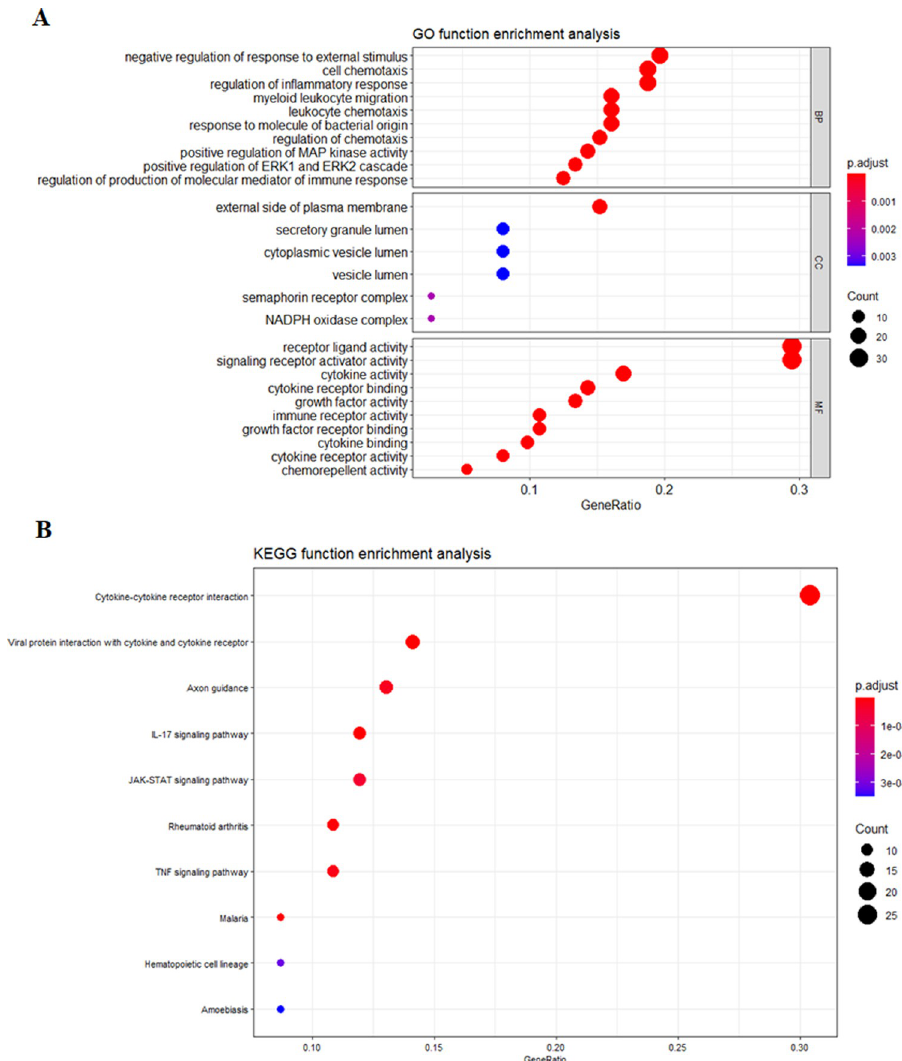
Fig 3. The mainly enriched (A) gene ontologies (GOs) and (B) KEGG pathways for 112 DEGs. The abscissa represents the number of genes enriched in the function. MF, molecular function; CC, cellular component; BP, biological process. (S1 Fig). The visualization of the main module using Cytoscape showed four hub proteins in